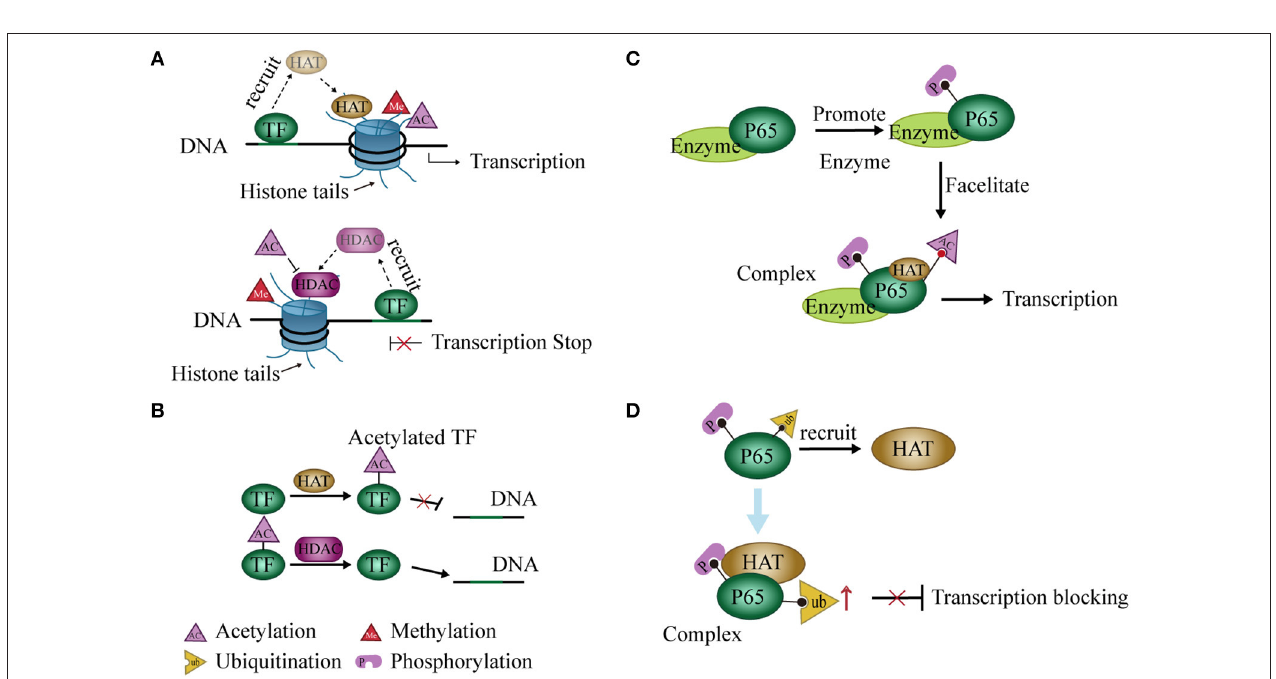
FIGURE 2 | Interaction between histone modification and transcription factors (TFs). (A) TFs recruit histone deacetylases (HDACs) or histone acetyltransferases (HATs) and regulate gene expression by promoting histone deacetylation or acetylation, respectively. (B) HDACs or HATs can act on TFs and interfere with binding to DNA. (C) Phosphorylation at some sites of p65 by related enzymes facilitates the acetylation of other sites, thereby promoting transcription of NF- κ B. (D) Phosphorylation of P65 recruits HATs to promote P65 ubiquitination and block